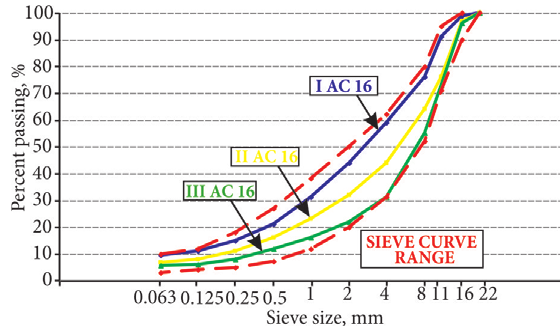
Fig. 2. Sieve size distributions of asphalt mixtures AC